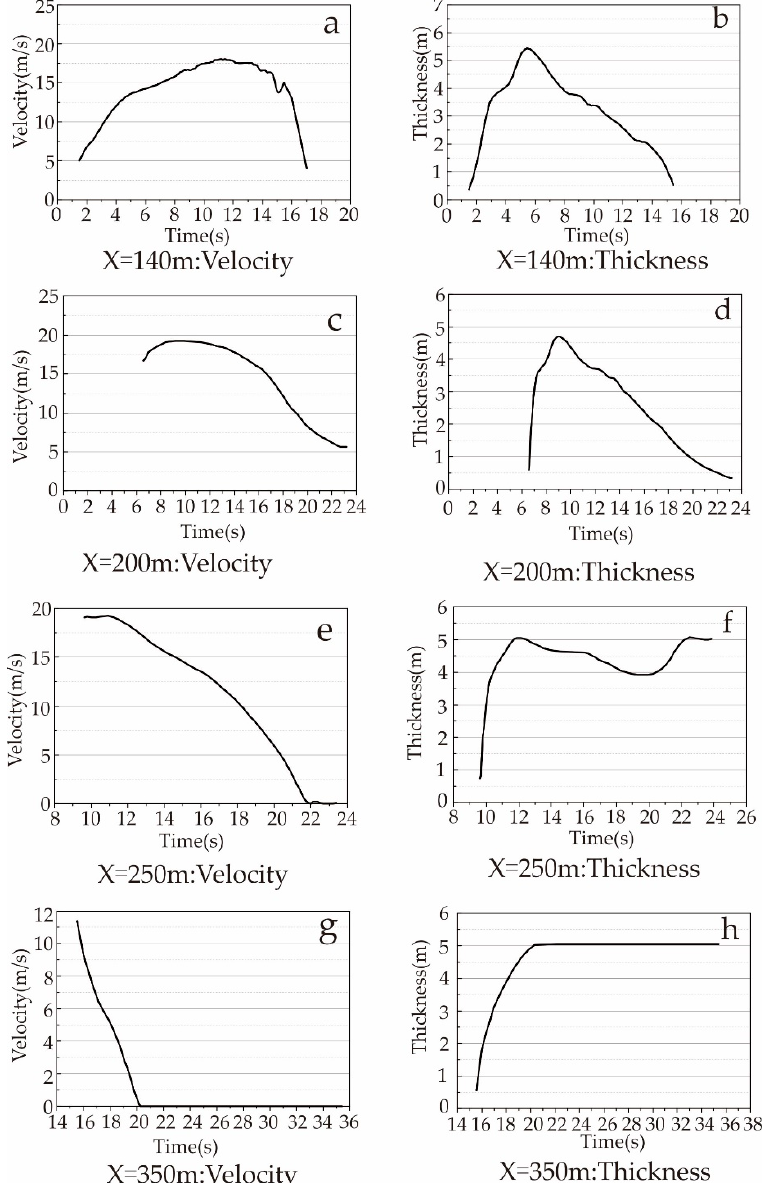
Figure 9. Typical point velocity and variation trend of the accumulation body.